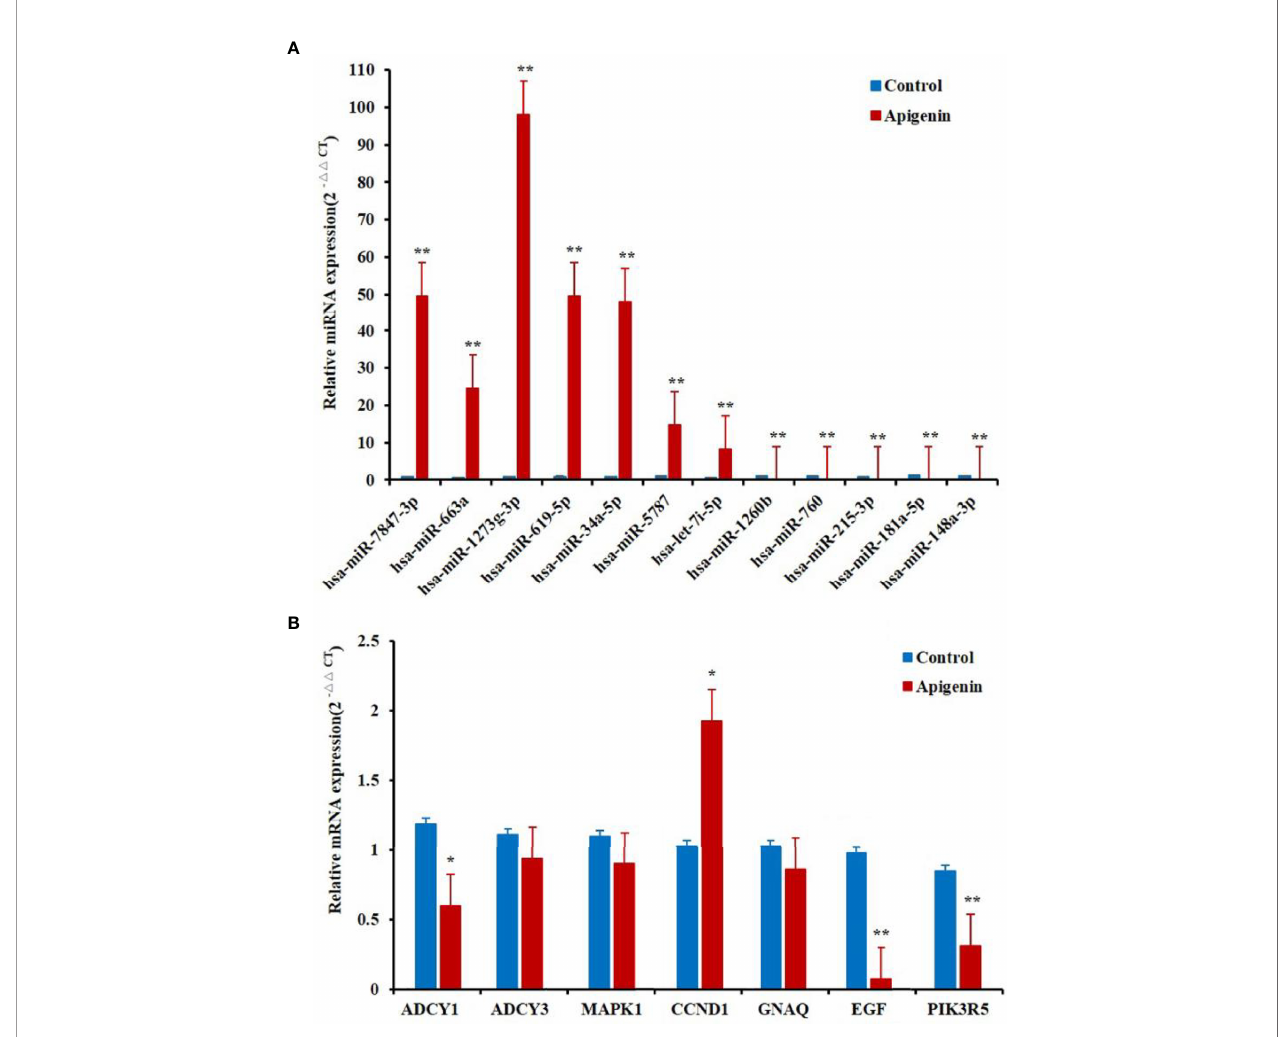
FIGURE 4 | Differentially expressed miRNAs and related target genes between apigenin-treated cells and the control group by RT-PCR. (A) The veri fi cation of the RNA-seq data by qPCR analysis of 12 miRNAs. (B) The notarization of the RNA-seq data by qPCR analysis of seven genes. * P < 0.05 and ** P < 0.01, compared with the control (0.1% DMSO) group. miRNAs and genes expression by